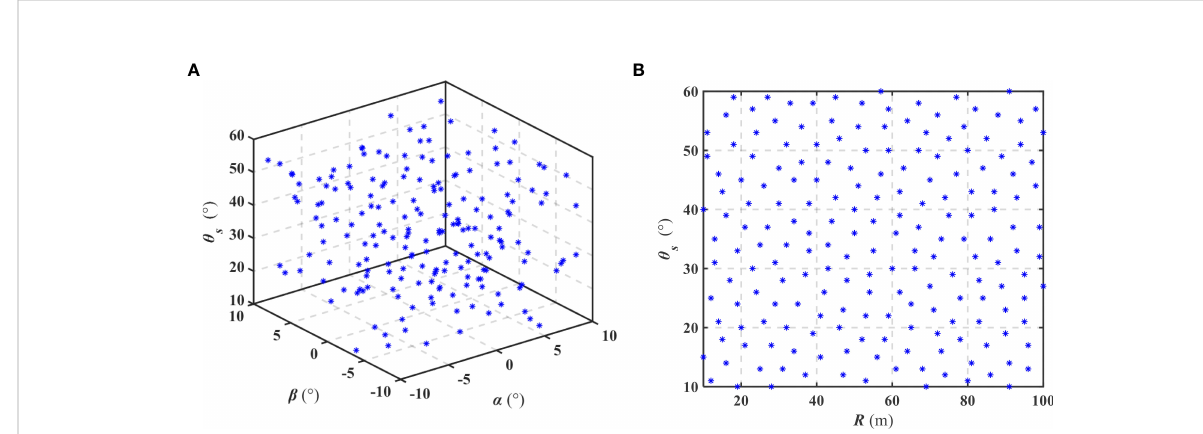
FIGURE 6 Sample points of the fl ume experiment (A) and rotating arm pool experiment (B) .